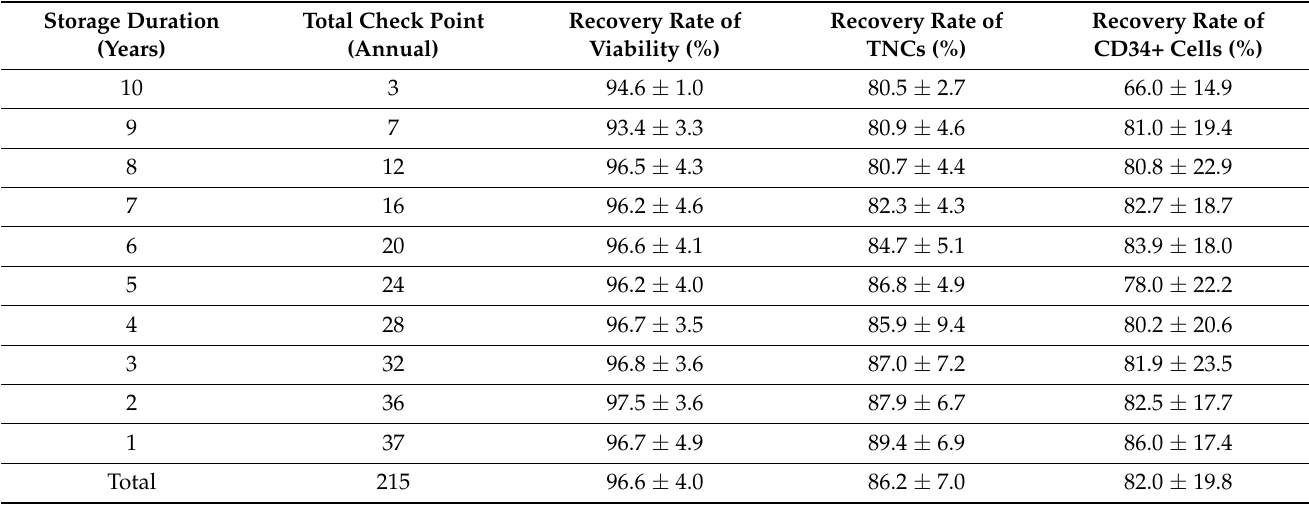
Table 1. Tracing of recovery rate of viability, TNCs, and CD34+ cells from 40 cryopreserved human umbilical cord blood units by checking CBs annually for 10 years (AVE ± SD, %).